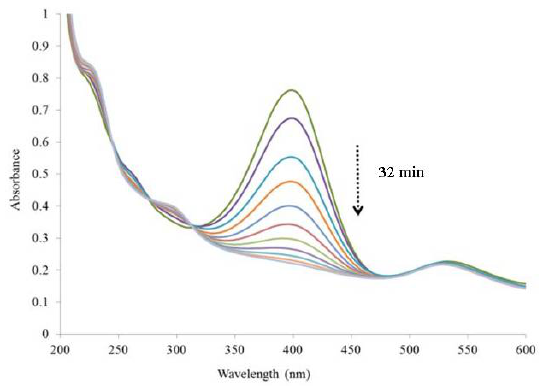
Figure 11. Recycling of AuNPs 1% tea (separated by centrifugation) as the catalyst in the reduction of 4-NP.